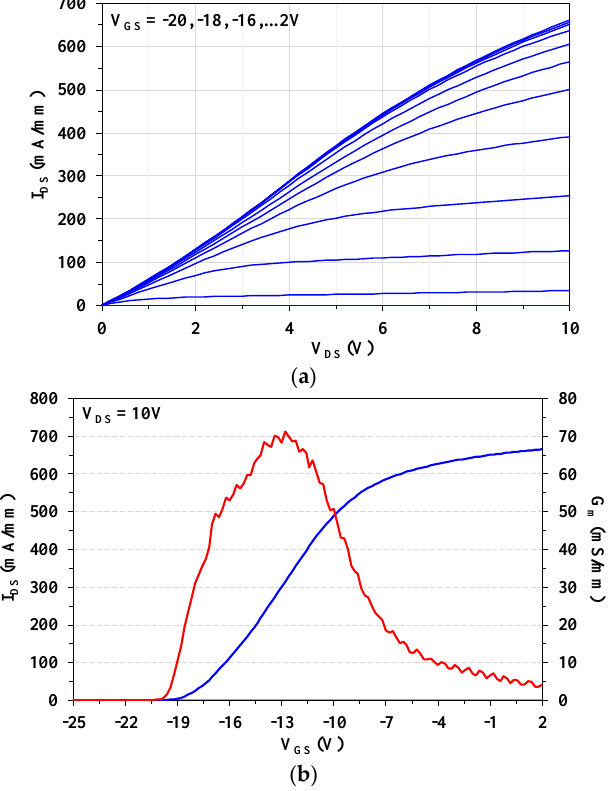
Figure 3. Representative device characteristics of AlGaN/GaN metal-insulator-semiconductor (MIS)–HEMTs used in this work. ( a ) Output characteristics (I DS -V DS ) measured at V GS from −20 to 2 V; ( b ) Transfer and transconductance characteristics (I DS -V GS , G m -V GS ) measured at V DS = 10 V.